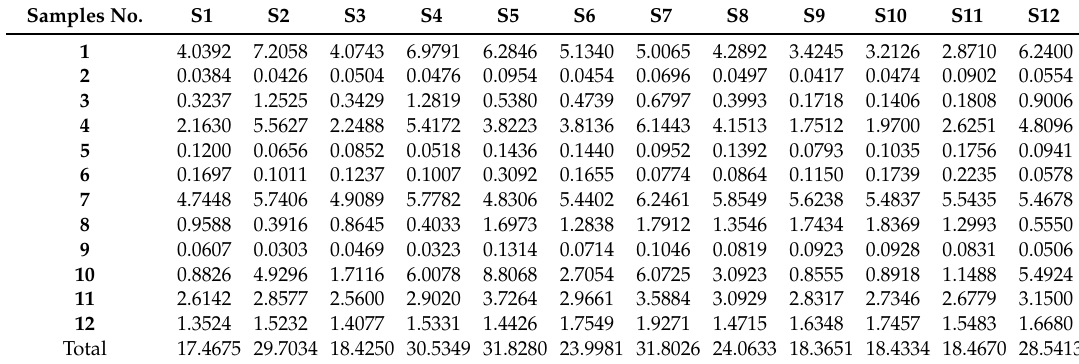
Table 5. Contents (mg/g) of the 12 bioactive constituents in the tested samples (mean, n = 3). Samples No.